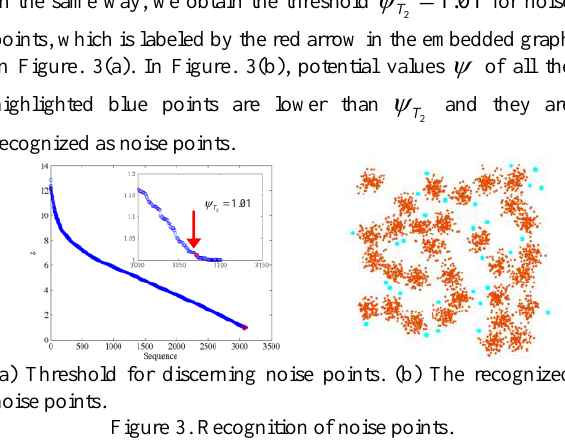
Figure 3. Recognition of noise points.